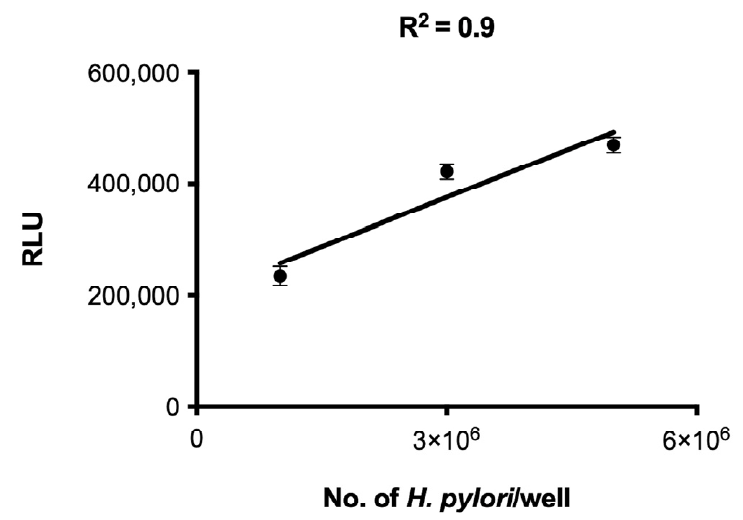
Figure 1. Correlation between H. pylori CFU and ATP bioluminescence in a 96-well microtiter plate. Different numbers of bacteria were seeded in a 96-well plate and ATP bioluminescence was measured after 24 h of incubation. Values plotted are the means and standard deviations of triplicate wells. The line represents a regression curve for the plotted data. RLU, relative light unit.